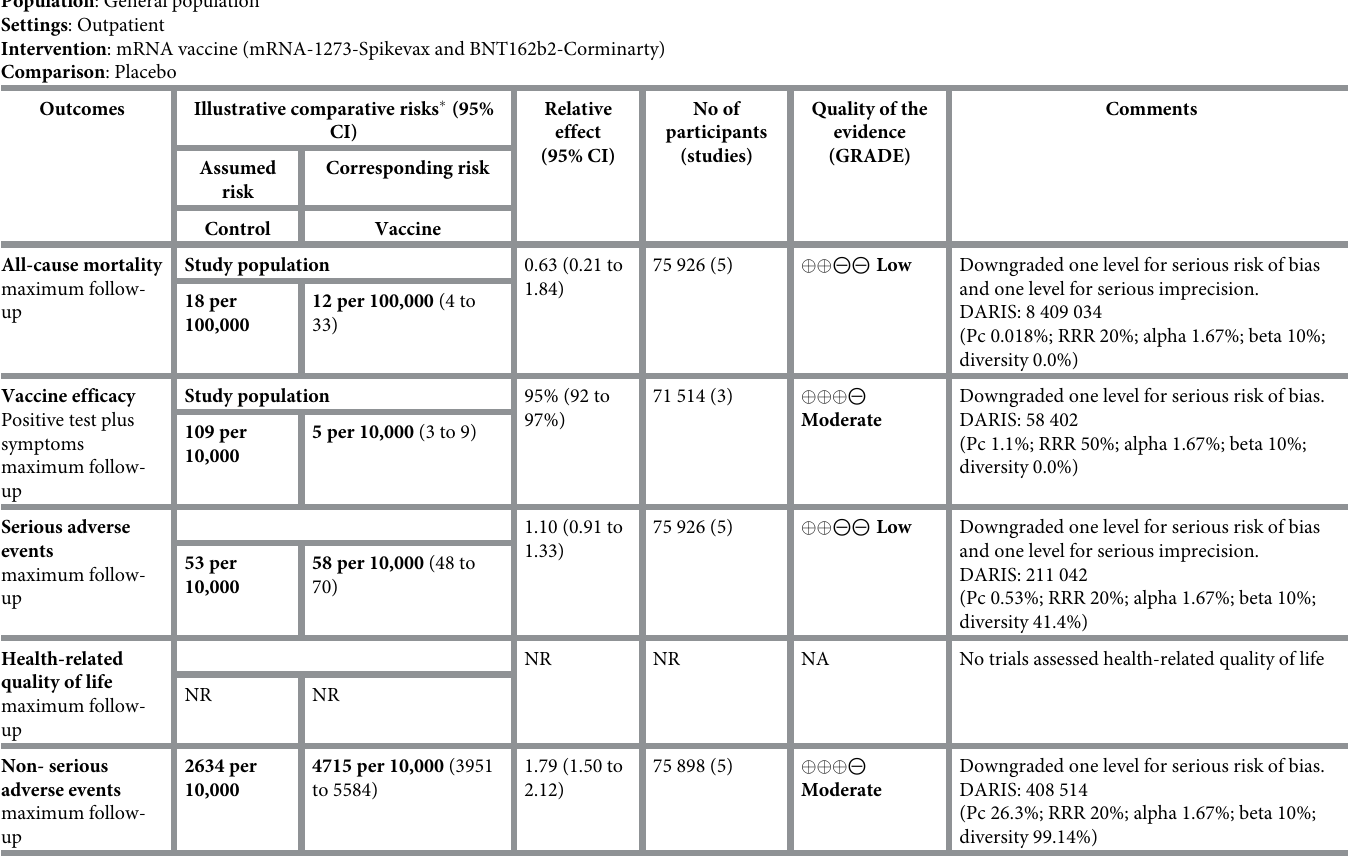
Table 2. Summary of findings (mRNA vaccines). mRNA vaccines versus placebo Population : General population Settings : Outpatient Intervention : mRNA vaccine (mRNA-1273-Spikevax and BNT162b2-Corminarty) Comparison :